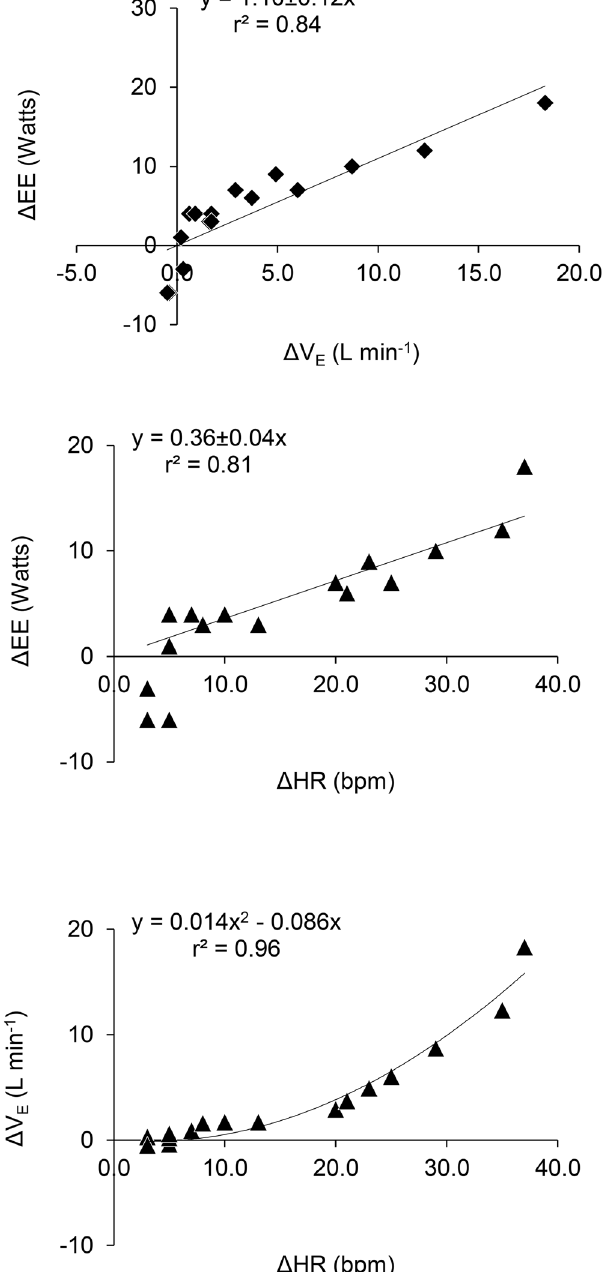
Figure 2. Changes in Δ EE versus in Δ V E (top panel), and changes in Δ EE versus in Δ HR (middle panel). Ordinary least squares linear regression equations, with intercept = 0, are shown. Changes in Δ V E versus in Δ HR (bottom panel). Second order polynomial regression equation, with intercept = 0, are